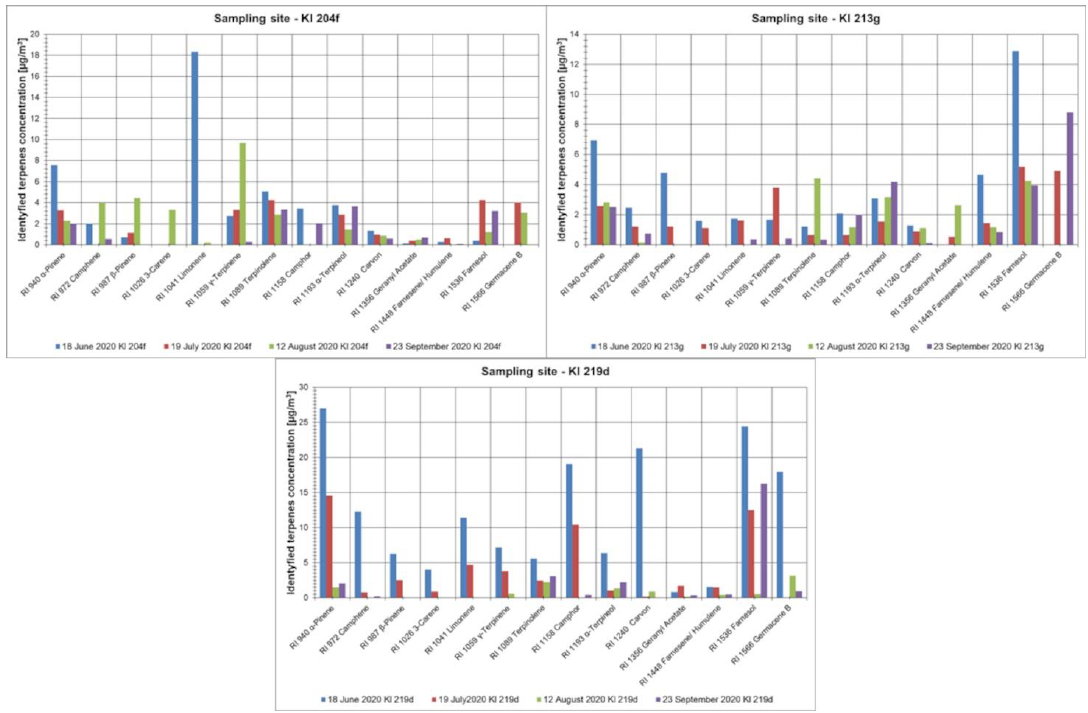
Figure A2. Distribution of concentrations of identified terpenes and terpenoids in atmospheric air over the Klapowka area for all measurement campaigns.